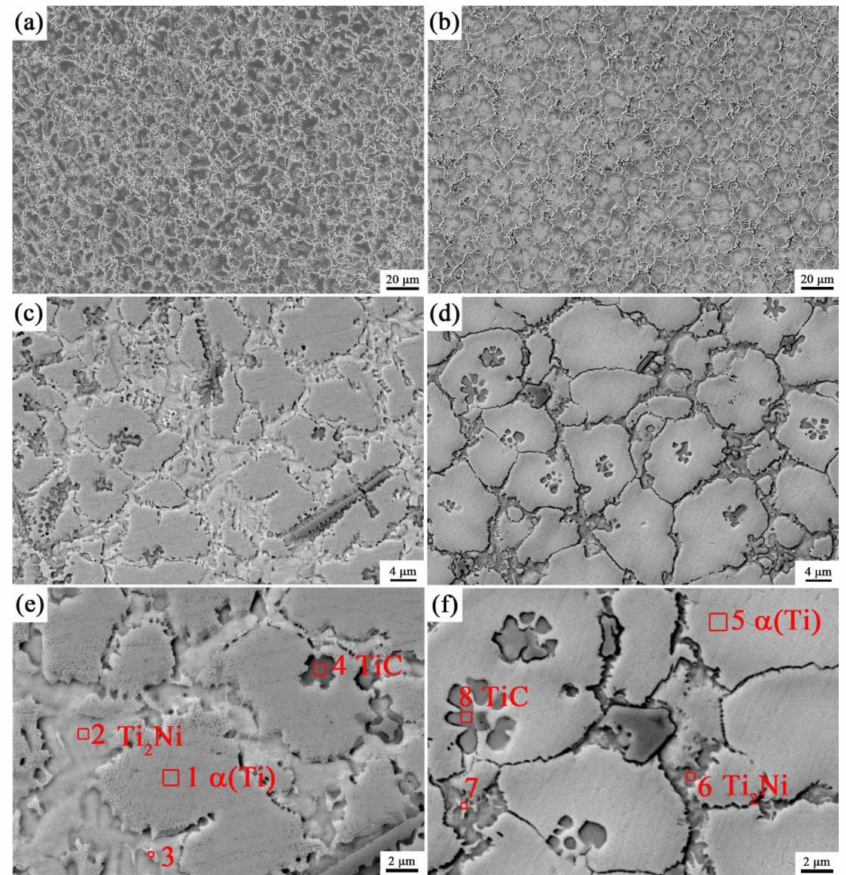
Figure 3. Microstructure of the coatings: ( a ) SE (secondary electron) image of coating without Ta; ( b ) SE image of coating with Ta; ( c , e ) BSE (back-scattered electrons) image of coating without Ta; ( d , f ) BSE image of coating with Ta.